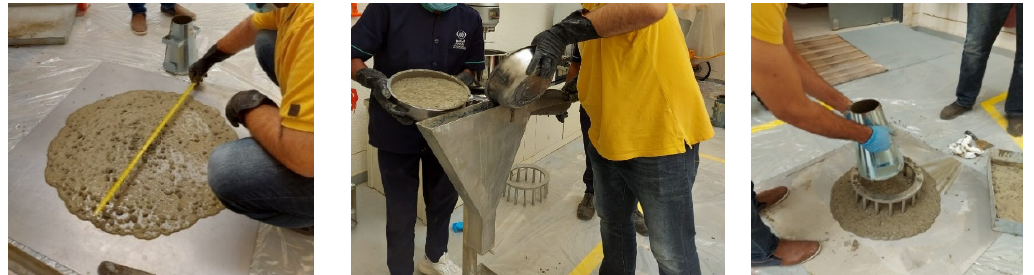
Figure 2. Flowability, V-funnel, and J-ring Tests.